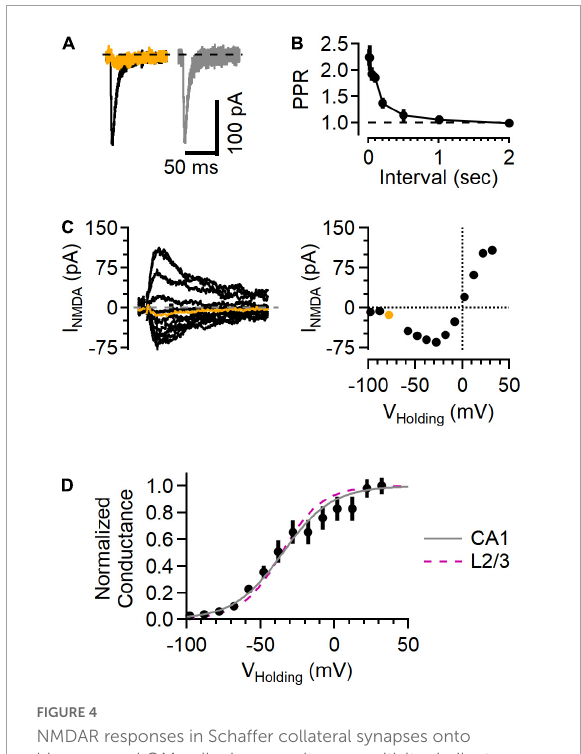
FIGURE4 NMDAR responses in Schaffer collateral synapses onto hippocampal CA1 cells show a voltage sensitivity similar to cortical L2/3 cells. (A) Example traces recorded from a hippocampal CA1 neuron upon stimulating Schaffer collateral inputs. Left, EPSC in “awake” ACSF (black) and after NBQX application (orange). Right, subtracted (NBQX-sensitive) AMPAR component of the EPSC (gray). (B) Paired-pulse response shows large facilitation at short intervals, typical of this synapse type. (C) Left, a family of NMDA current responses at different voltages and the current voltage relationship (right), with the measurement while holding at –78 mV highlighted in orange. (D) Normalized conductance versus voltage from 5 recordings (black symbols, Mean ± SEM). Gray line is a fit to these data ( a = 0.12, b = –0.061, with the midpoint –35.0 mV), and the fit from the L2/3 recordings in awake ACSF (from Figure 3 ) is shown as a dashed fuchsia line for